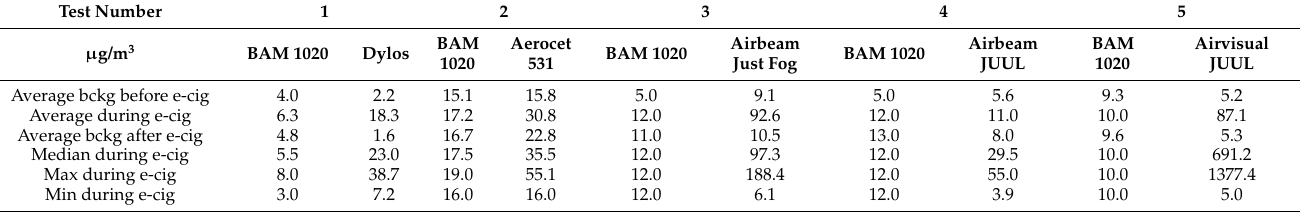
Table 2. Summary of all tests: Dylos, Aerocet 531, Airbeam Just Fog, Airbeam JUUL and Airvisual